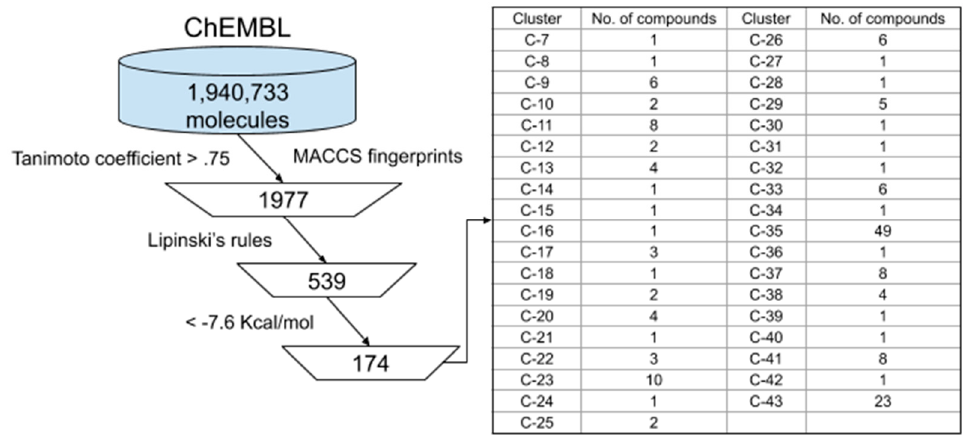
Figure 3. Virtual screening of compounds from ChEMBL. Selected compounds were classified into 37 clusters based on the MACCS fingerprint similarity.